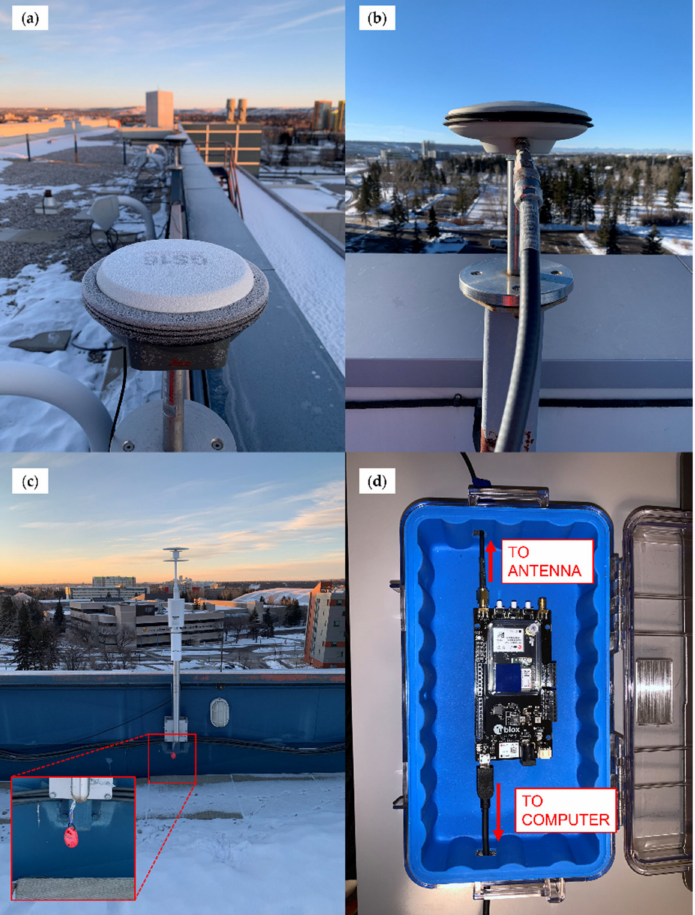
Figure 2. Equipment used for testing consisted of: ( a ) GS16R (near) and GS16B (far) receivers installed on permanent pillars for static testing; ( b ) NovAtel GPS-703-GGG antenna connected to antenna cable network for static testing; ( c ) Kestrel DROP D3 environmental data logger installed in shaded location of static test location; ( d ) C099-F9P board of F9PBLU receiver in protective case used for kinematic testing indicating antenna and computer